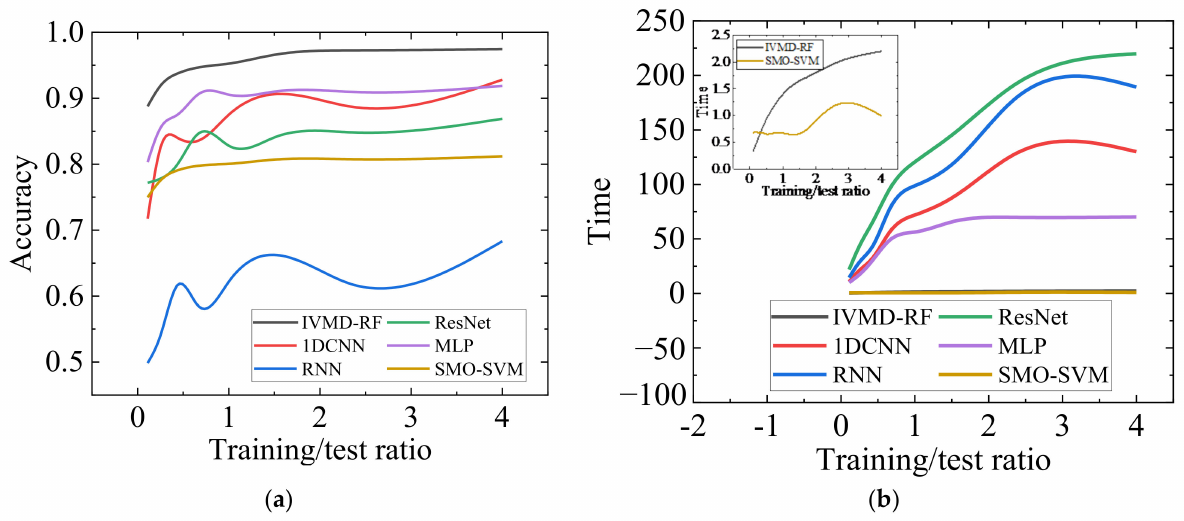
Figure 11. Comparison of each algorithm with different training/testing ratios (0.1 to 4). ( a ) Compar- ison of accuracy. ( b ) Comparison of the training time.